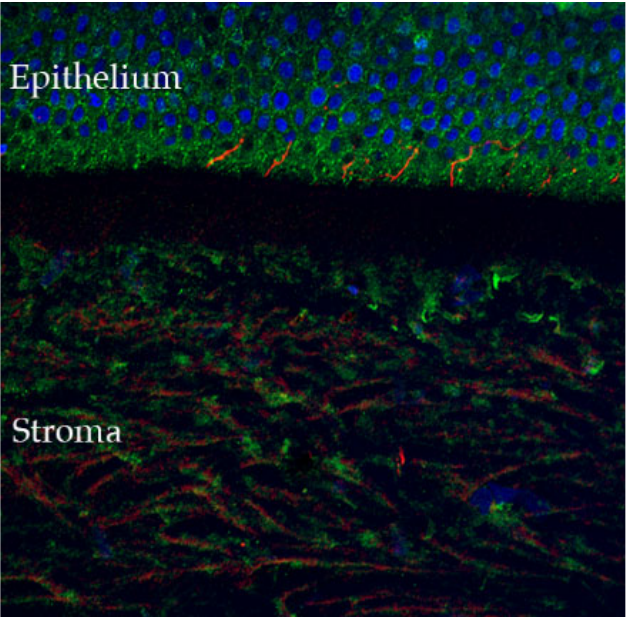
Figure 2. Confocal microscopy-evidenced immunostaining of corneal nerves (in red) in a healthy human cornea sample (×40 magnification). Of note, the corneal fibers that penetrate in the corneal epithelium, where they participate in stromal-epithelial interactions (detailed in Section 2.4) (DAPI (blue) was used to stain the epithelial cell nuclei).